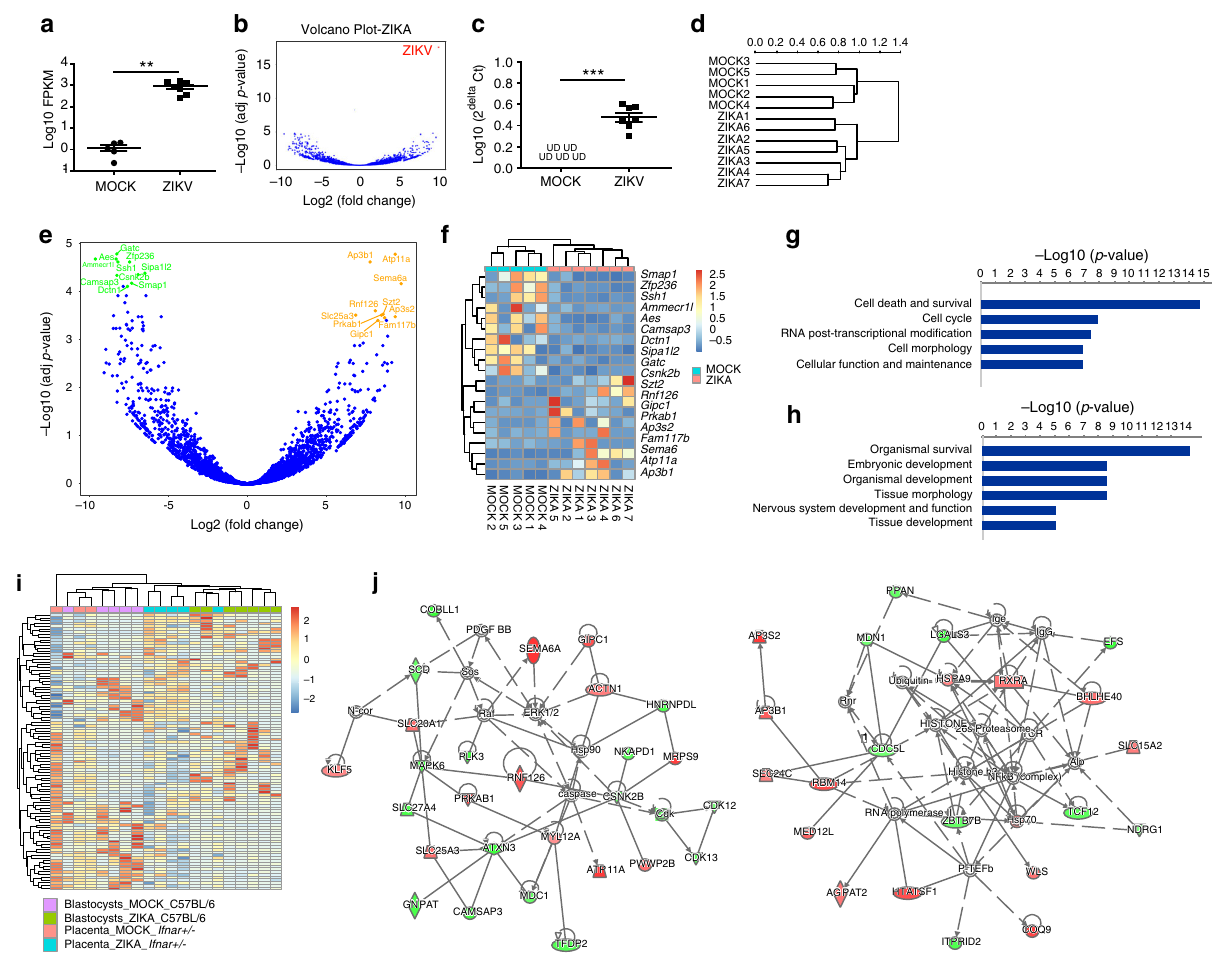
Fig. 2 Single-blastocyst RNA-seq analysis of ZIKV-infected mouse blastocysts. a FPKM value of ZIKV vRNA in Mock or ZIKV-infected mouse blastocysts. n = 5 for MOCK, n = 7 for ZIKV. b Volcano plot of total RNA (including both mRNA and vRNA) of Mock or ZIKV-infected mouse blastocysts. ZIKV vRNA indicated in red. c qRT-PCR analysis of ZIKV vRNA in Mock or ZIKV-infected mouse blastocysts. n = 5 for MOCK, n = 7 for ZIKV. d Clustering analysis of Mock or ZIKV-infected mouse blastocysts. e Volcano plot of total mRNA of Mock and ZIKV-infected mouse blastocysts. Top 10 upregulated genes in ZIKV-infected blastocysts are highlighted in orange color. Top 10 downregulated genes in ZIKV-infected blastocysts are highlighted in green color. p adj < 0.05, calculated by Wald test for differential expression with Benamini and Hochberg adjustment for multiple comparisons. f Heatmap of top 10 upregulated and downregulated genes in ZIKV versus mock-infected mouse blastocysts. Upregulated genes are demarked by red color and downregulated genes are demarked by blue color. g , h Ingenuity Pathway Analysis of cellular and molecular ( g ) and physiological ( h ) pathways that are signi fi cantly changed in ZIKV versus mock-infected mouse blastocysts. i Heatmap and clustering analysis (Top 50 upregulated and downregulated genes) of MOCK versus ZIKV-infected mouse blastocysts with MOCK versus ZIKV-infected mouse placentas ( Ifnar + / − ) in vivo. Color scale is set up with red as upregulation and blue as downregulation. j Ingenuity Pathway Analysis (IPA) of Top 50 upregulated and downregulated genes, which were analyzed in i . Upregulated genes are demarked by red color and downregulated genes are demarked by blue color. UD – undetectable. Data are presented as mean ± standard deviation. P values were calculated by unpaired two-tailed Student ’ s t- test. ** P < 0.01, and *** P < 0.001. Source data for 2a,c are provided as